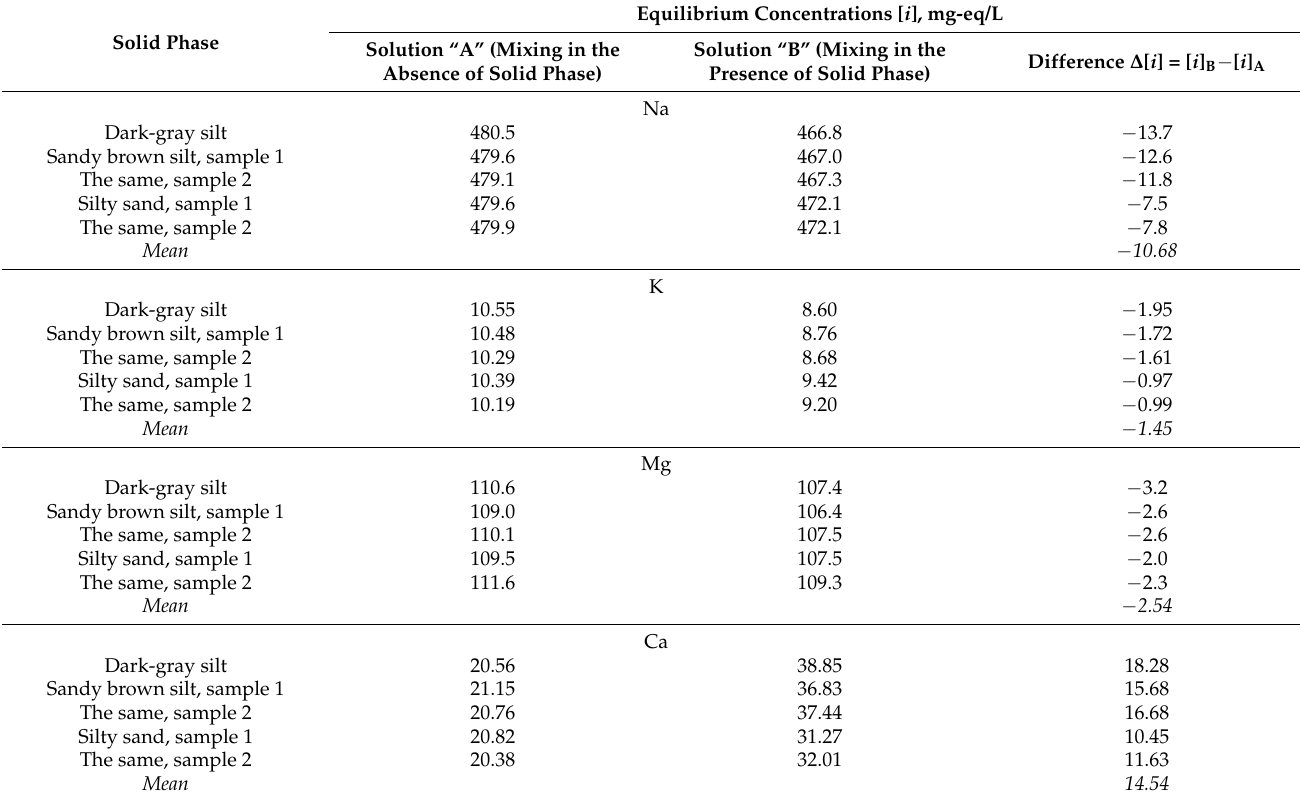
Table 1. Changes in the composition of the adsorbed complex of freshwater terrigenous material at the interaction with seawater 1 .